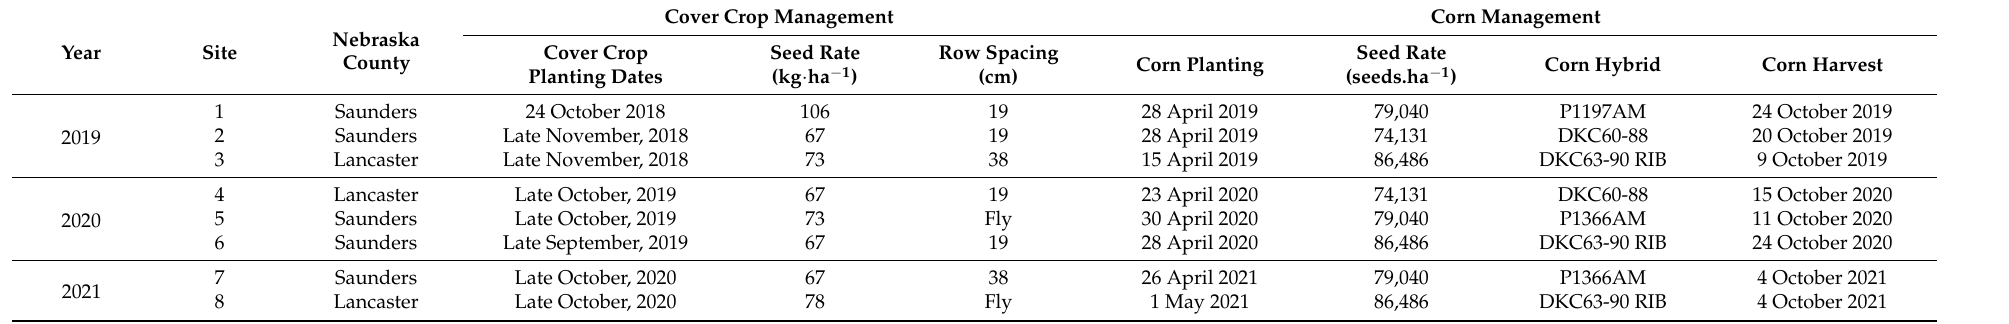
Table 1. Cereal rye and corn management dates and specifications per site and year.